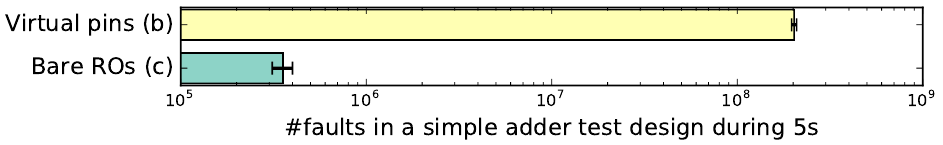
Figure 6: Amount of errors detected in a simple adder test design during 5 seconds of RO toggle activation with respect to the RO implementation option. Tested on